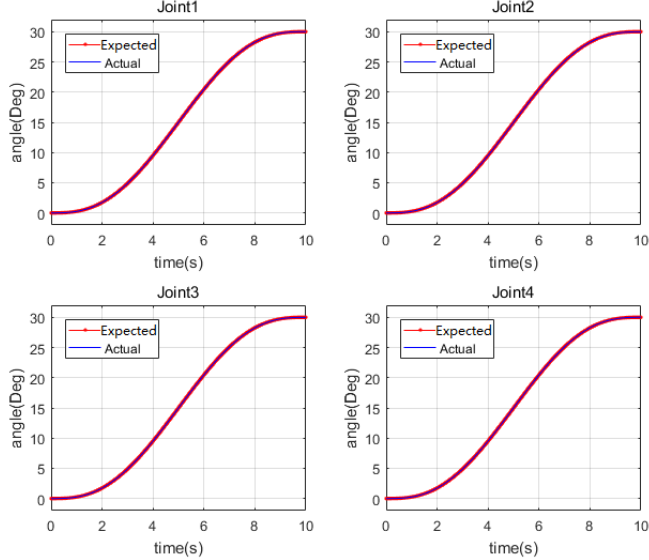
Figure 9. The motion of four joints under no load.